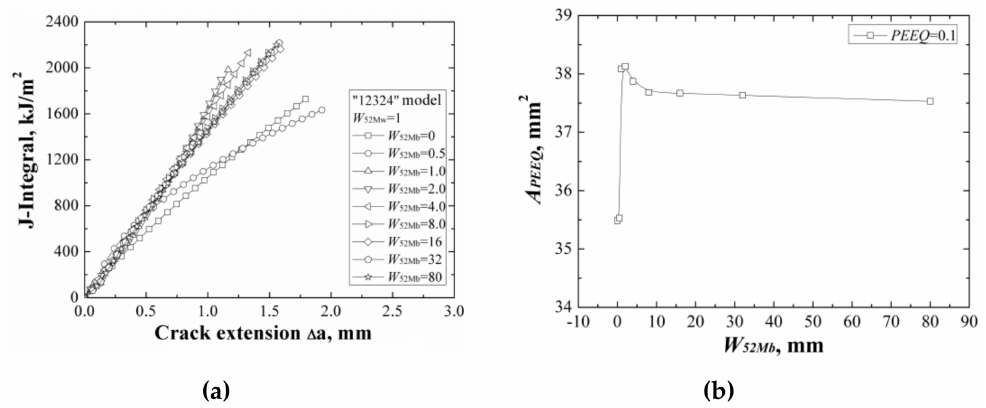
Figure 12. The J -resistance curves ( a ) and the areas surround by the ε p = 0.1 isoline ( b ) of different “12324” models with the same W 52Mw .